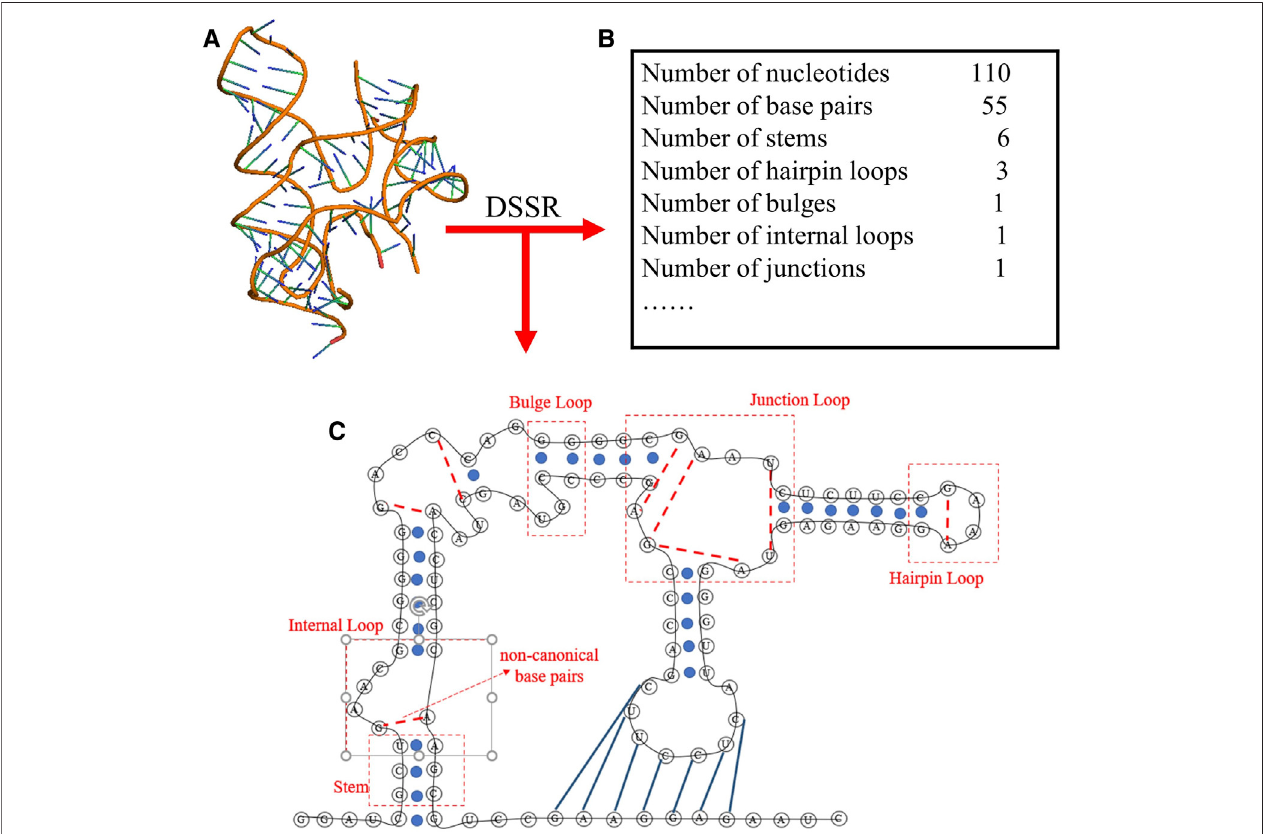
FIGURE 3 | The schematic diagram of the secondary structure information extracted from an RNA 3D structure (ydaO riboswitch, PDB ID: 4QLM) using DSSR softwareinRNAStat. (A) 3DstructureshownwiththePyMol(http://www.pymol.org)fortheRNA. (B) TheDSSRsoftwareiscalledtoanalyzetheRNA3Dstructures,e.g., for the RNA, the secondary structure information including the details of canonical/noncanonical base pairs, stems, and various loops. (C) The secondary structure drawn based on the secondary structure information from (B) for the RNA. Black lines: backbone. Blue solid circles and blue solid lines: canonical base pairs (A-U, G-C, and G-U). Red dotted lines: non-canonical base pairs. Dashed boxes: samples of secondary structural